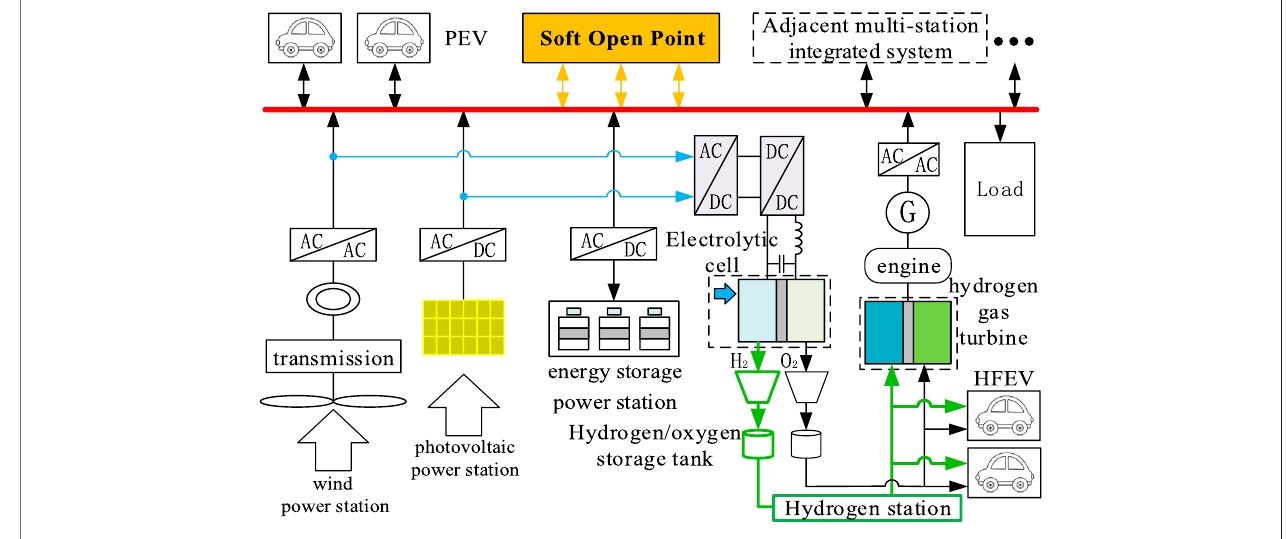
FIGURE 2 | Schematic diagram of internal hydrogen/electric energy fl owed and conversion.